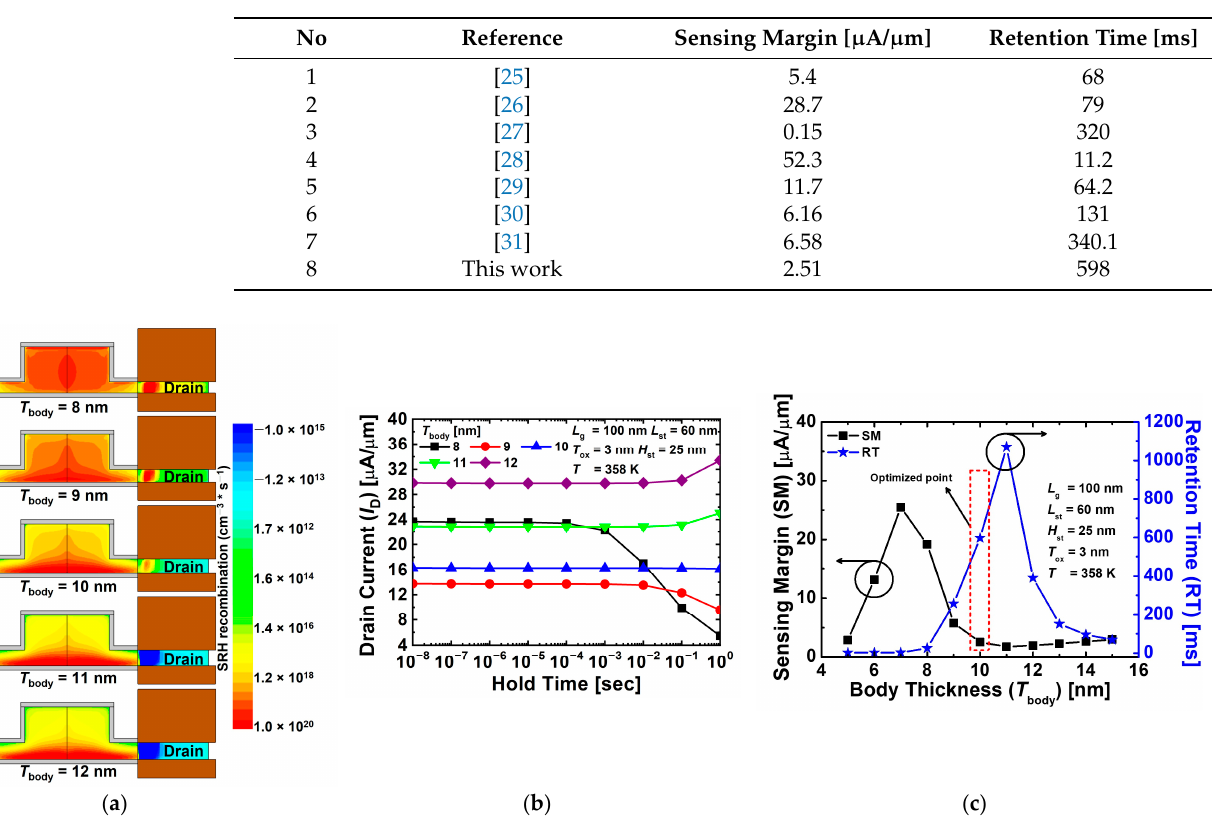
Table 3. Memory performance of various 1T-DRAM-related papers.